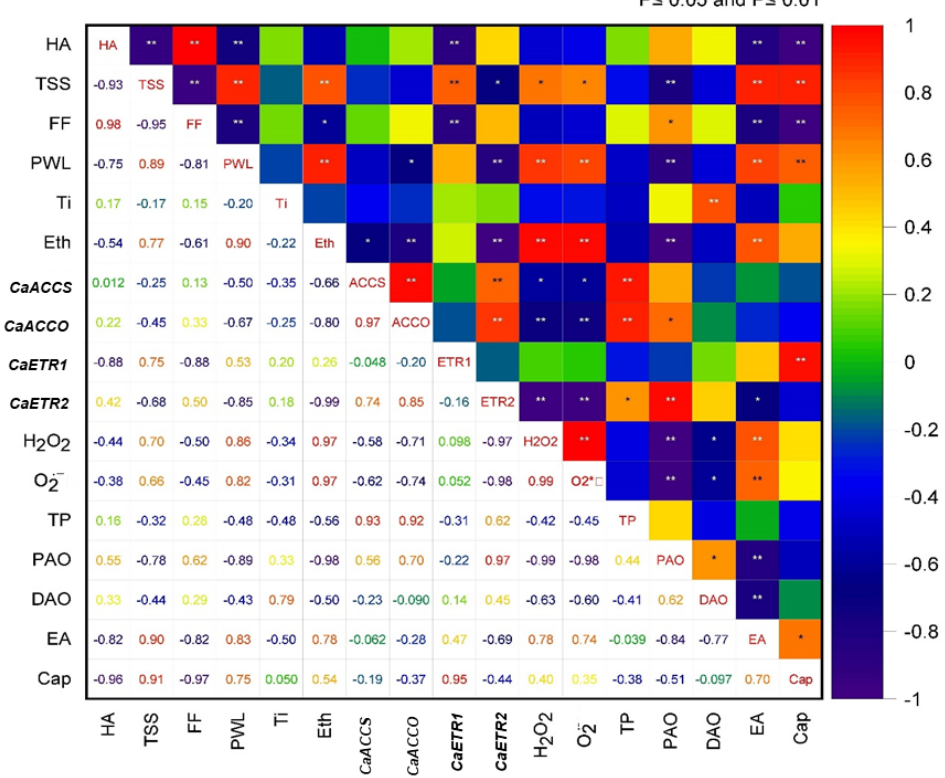
Figure 13. Correlation matrix heatmap of significant attributes in modulation ripening process under treatments. Here, lower triangle represents correlation values and upper triangle represents the significance levels (* and ** represent significance level at p ≤ 0.05 and p ≤ 0.01, respectively) between different parameters. HA-Color in hue angle, TSS-Total Soluble Solid Content, FF-Firmness of fruit coat, PWL-Percentage of water loss, Ti-Titanium accumulation, Eth-Ethelene content, ACCS-expres-